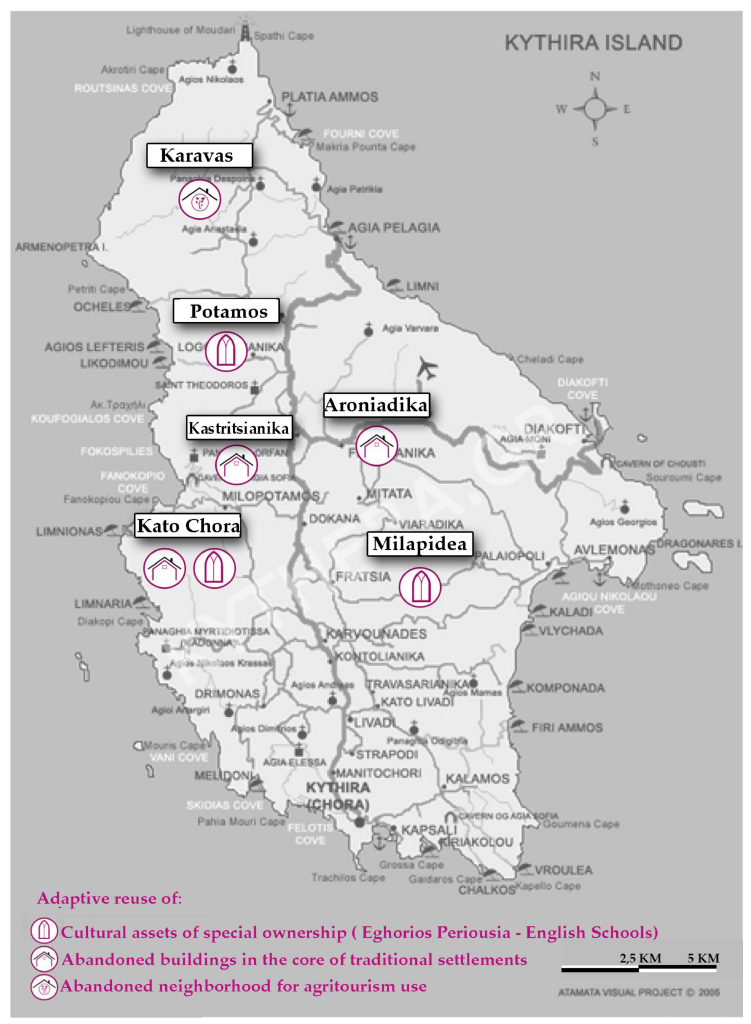
Figure 13. Map of the proposal schemes for the sustainable preservation of traditional settlements and cultural assets according to the principles of circular economy in Kythera, modified after